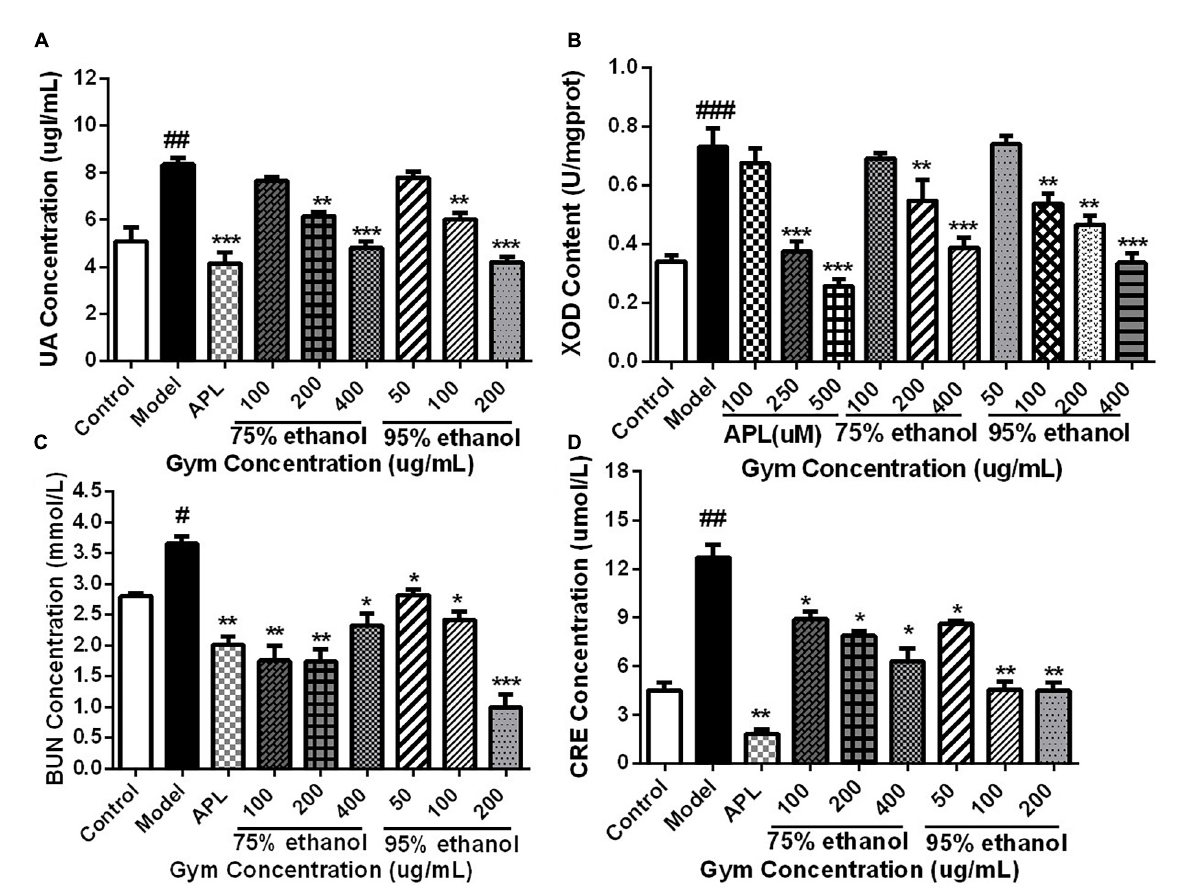
FIGURE7 The effects of ethanolic extracts of Gym on UA-related indexes of HUA zebrafish. (A) The effect of ethanolic extracts of Gym on UA content. (B) The effect of ethanolic extracts of Gym on XOD content. (C) The effect of ethanolic extracts of Gym on the content of BUN. (D) The effects of ethanolic extracts of Gym on CRE content. * P < 0.05, ** P < 0.01, *** P < 0.001. # P < 0.05, ## P < 0.01, ### P <